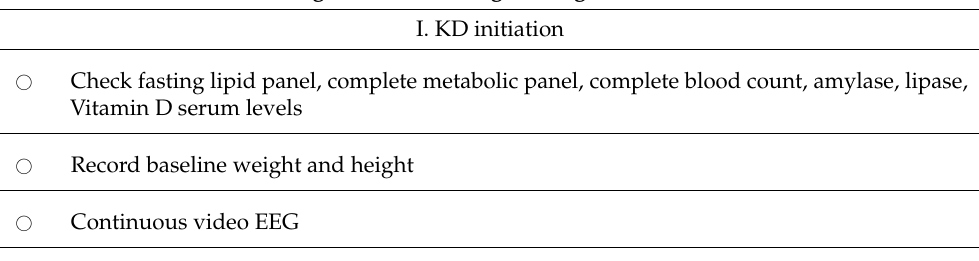
Table 3. Ketogenic Diet checklist for Status Epilepticus. Pearls to Consider for Starting and Maintaining a Ketogenic Diet